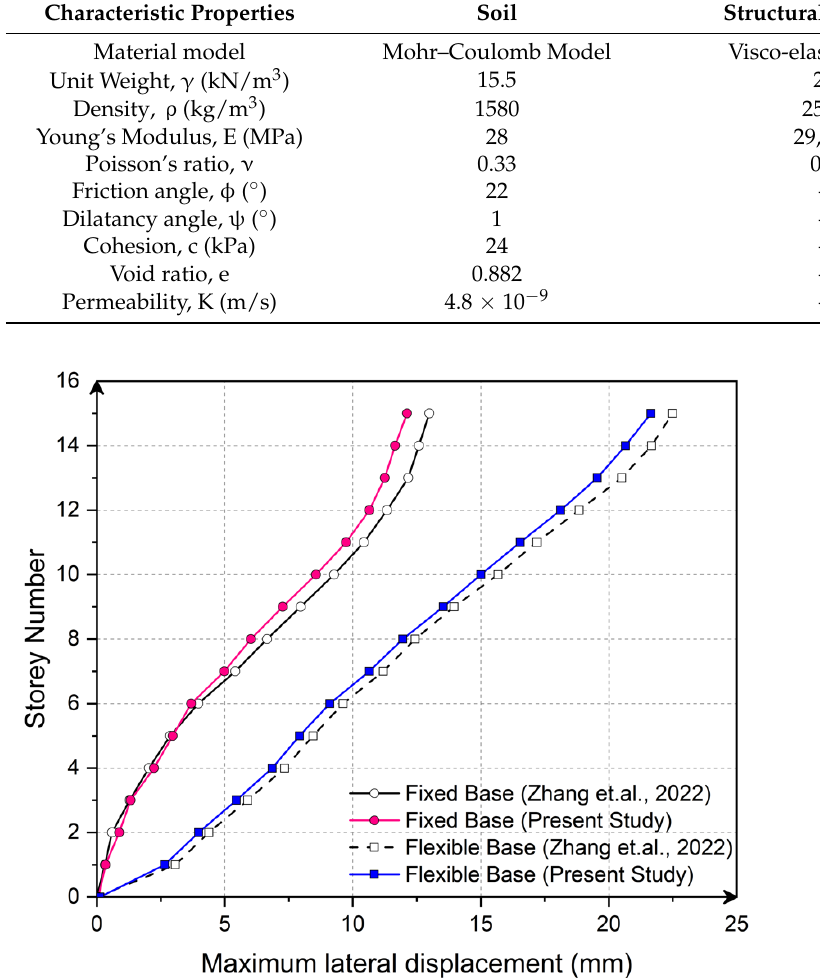
Figure 4. Variations between the lateral displacement, story height, and validation of the present model using the work of Zhang et.al. [8].